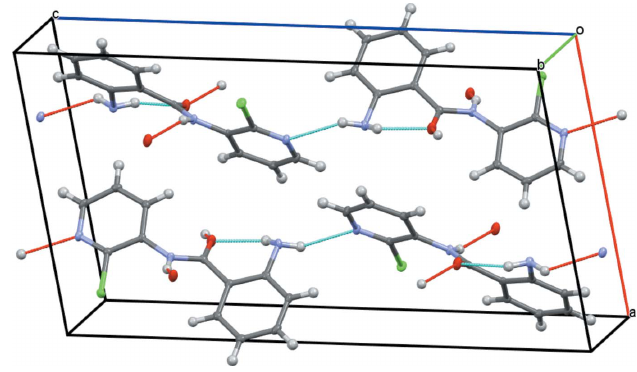
Figure 2 Aview along the c axis of the packing. Hydrogen bonds (see Table 1) are shown as dashed lines.